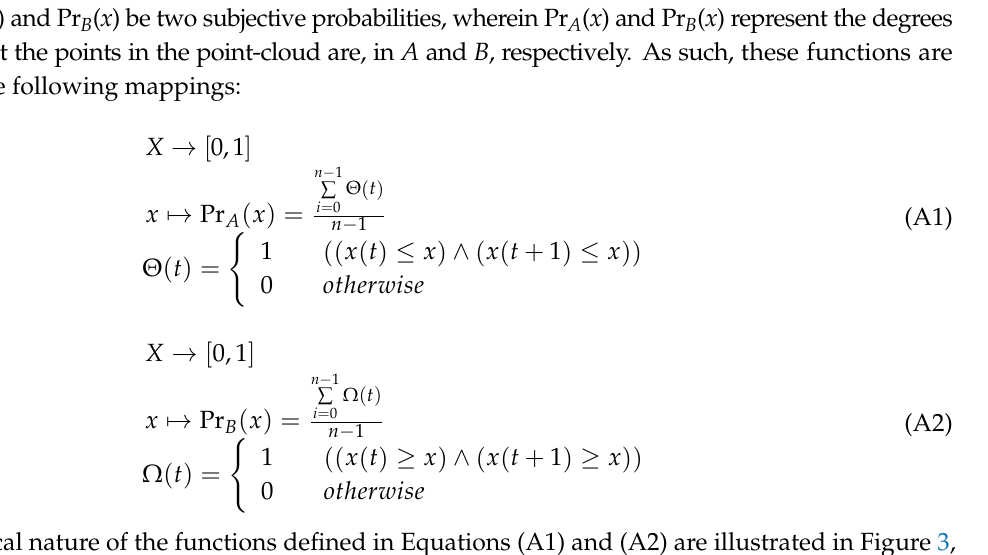
Figure A4. Nature of Pr A ( x ) + Pr B ( x ) and min(Pr A ( x ), Pr B ( x )) for unimodal data.